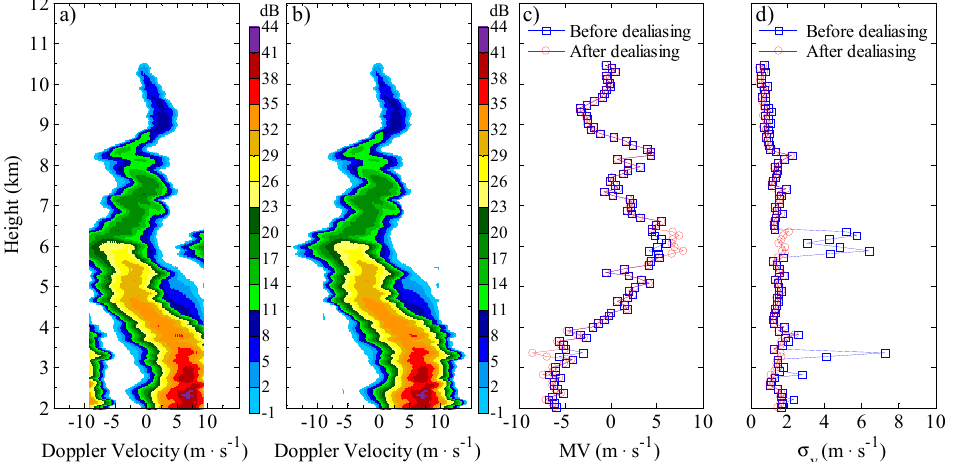
Figure 3. A velocity dealiasing case made from a convective cloud collected at 10:00 UTC on 5 July 2014 by CI mode; ( a ) is the original Doppler spectra at different heights; ( b ) is the corresponding corrected spectra after dealiasing; ( c ) is the estimated MV from ( a , b ); and ( d ) is the σ v estimated from ( a , b ). The power of Doppler spectra denoted by dB, which represents an analog-to-digital (A/D) converter count and can be converted to dBm by 10 × log 10 dB minus the radar receiver gain.